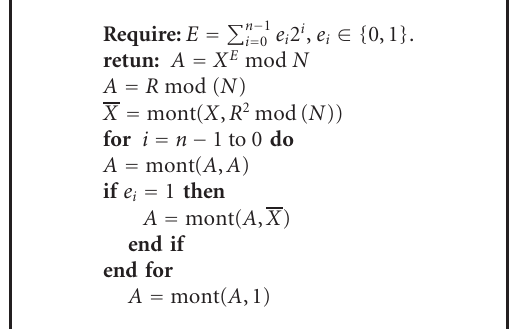
Algorithm 2: Montgomery modular exponentiation—square and